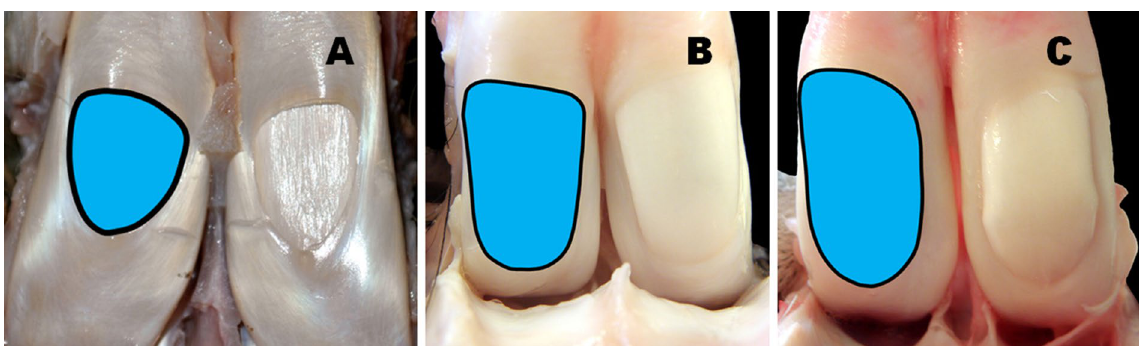
Figure 2. Variable shapes of the “oval window” in the manica flexoria of the pectoral limb (view of the adductor area). ( A ) Reindeer, ( B ) Domestic sheep, ( C ) Beisa oryx. Photos by M. P.